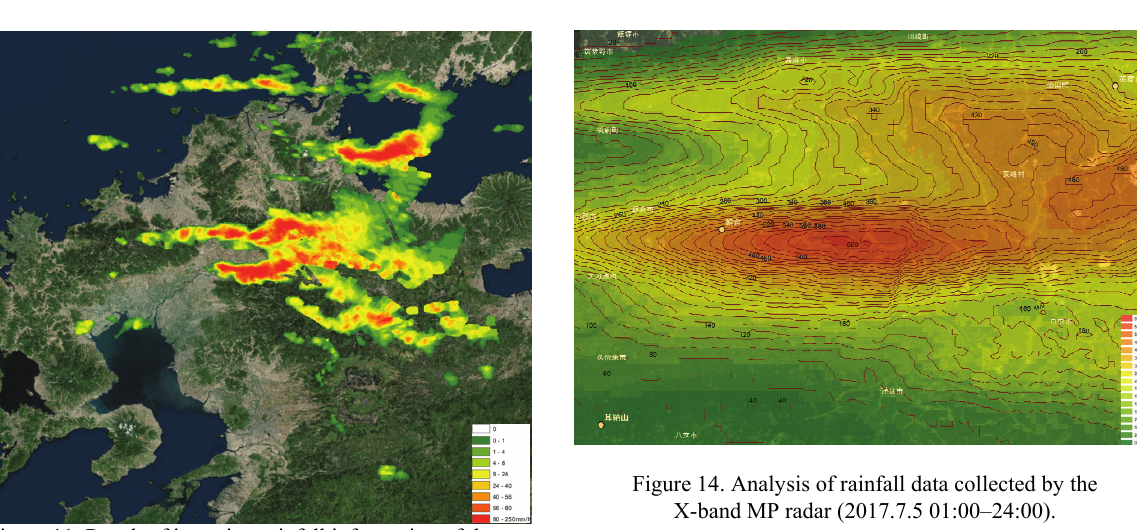
Figure 11. Result of inputting rainfall information of the X-band MP radar into GIS (2017.7.5 16:00).